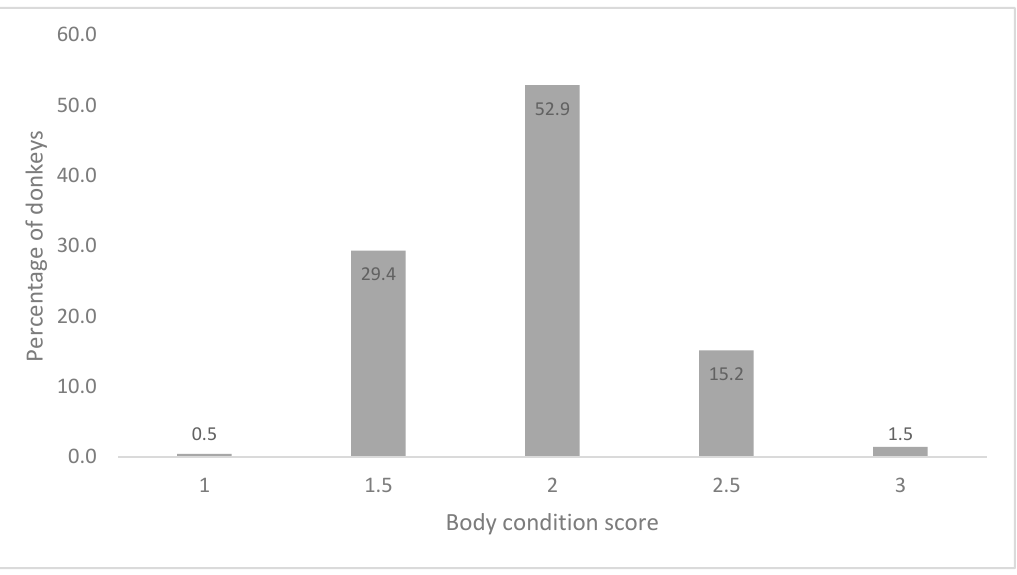
Figure 5. Body condition score for donkeys included in the assessment, scores of 4 (fat) and 5 (very fat) were not given.